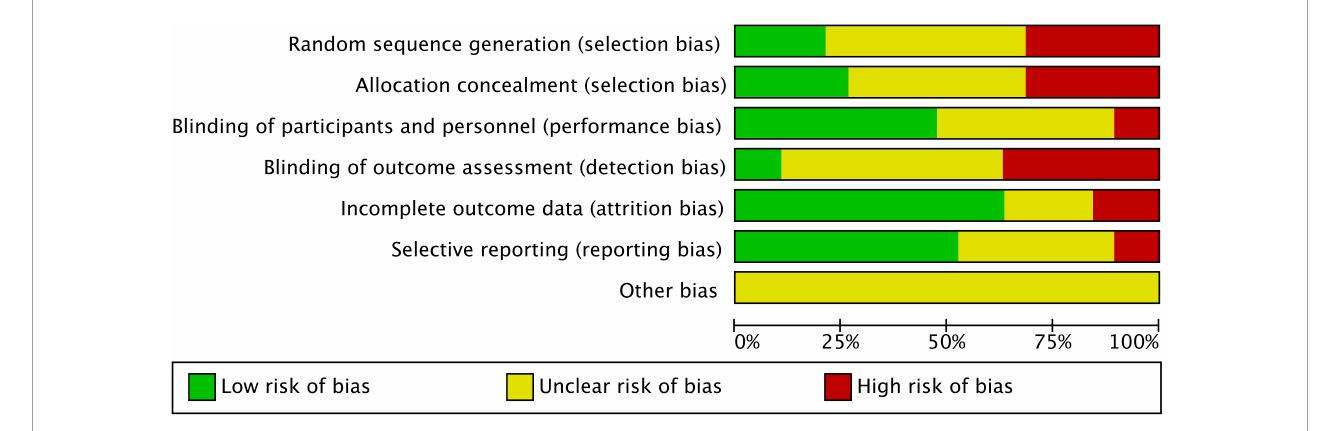
FIGURE2 Risk of bias